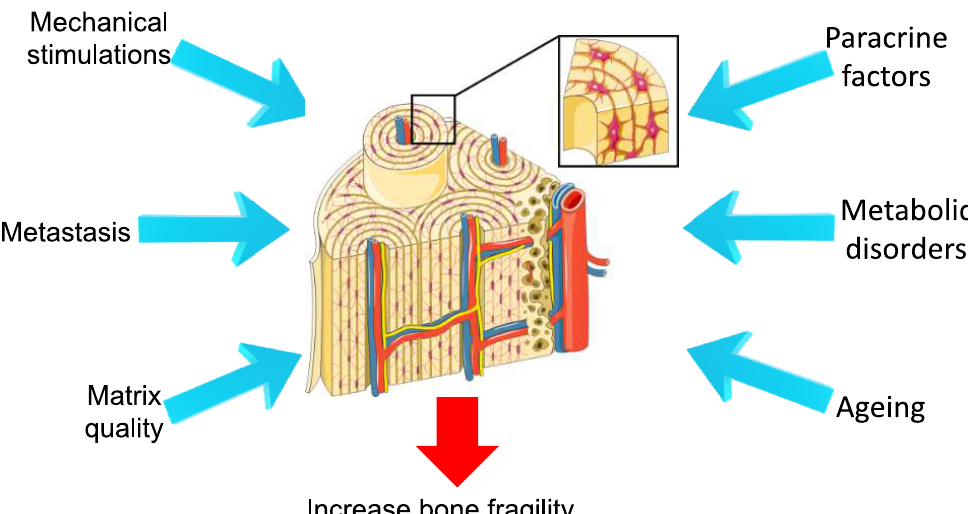
Figure 1. Parameters influencing bone remodeling. Human cortical bone is formed of Haversian canals surrounding by concentric lamellae and form osteons that are bond together by cement line. During ageing or due to several diseases there is an imbalance of the remodeling which changes the capacity of cells to respond to a treatment or support the osteointegration of an